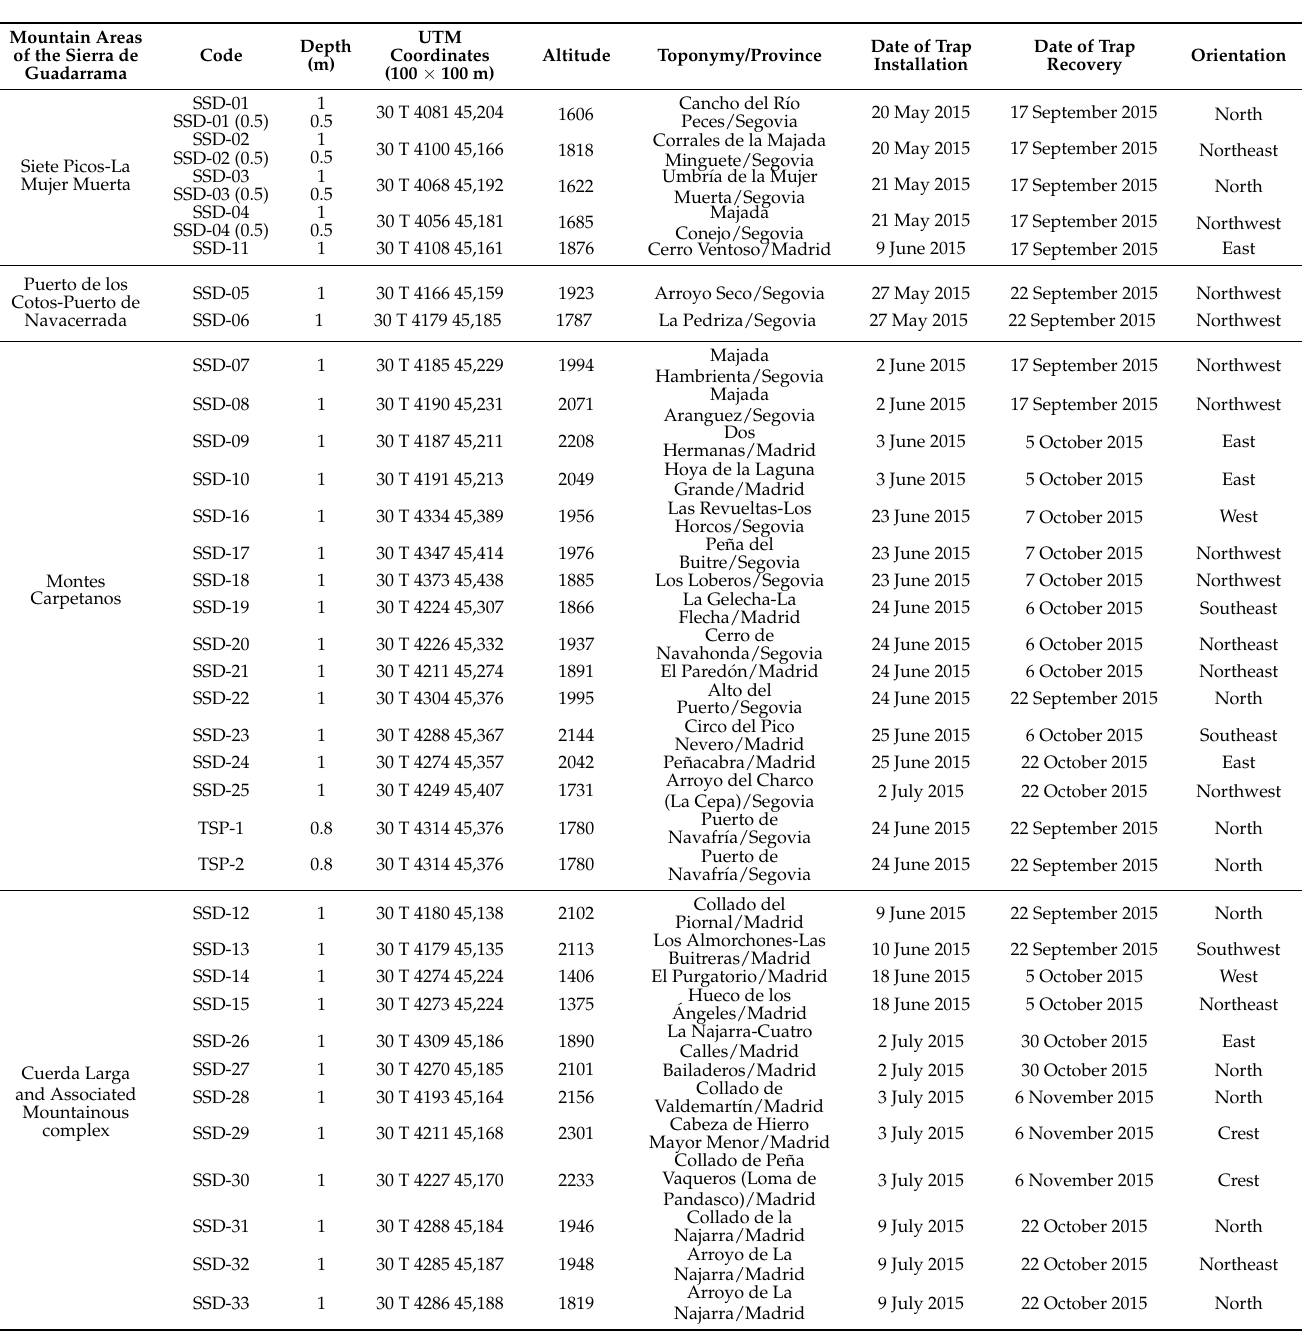
Table 1. Location of the traps in the mountain areas of the Sierra de Guadarrama. Values: depth: meter; UTM coordinates: 100 × 100 m; altitude: m a.s.l. Abbreviations: SSD, subterranean sampling